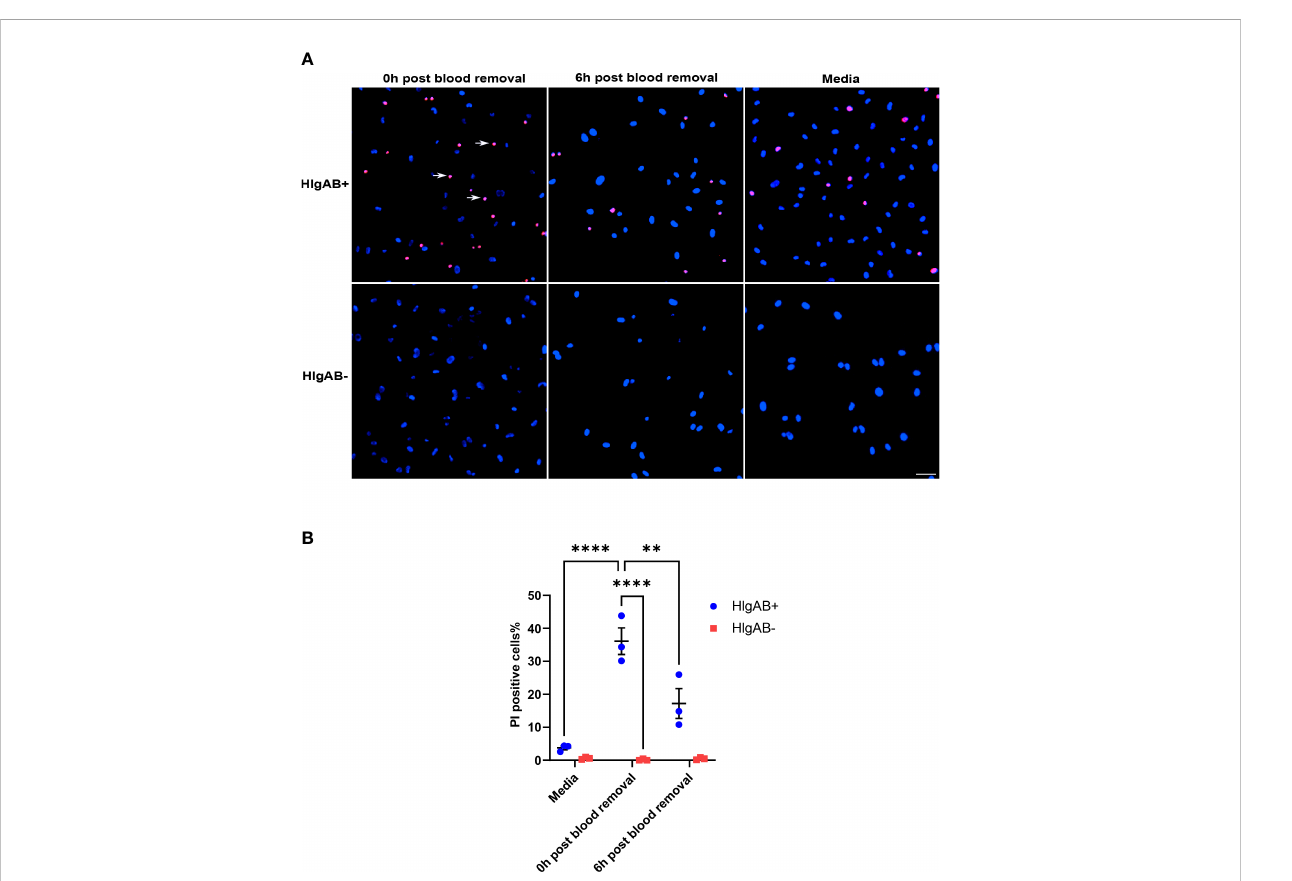
FIGURE 5 Susceptibility to the leukocidin HlgAB decreases as ACKR1 is cleared upon blood removal. (A) HPMECs were pre-incubated with blood for 24 hours. Either immediately after or 6 hours after blood was removed, cells were exposed to HlgAB for 1h. Apoptotic endothelial cells were detected by propidium iodide (PI) uptake (see white arrow in representative images). (B) Quanti fi cation of PI-positive cells among total cells (**p<0.01;